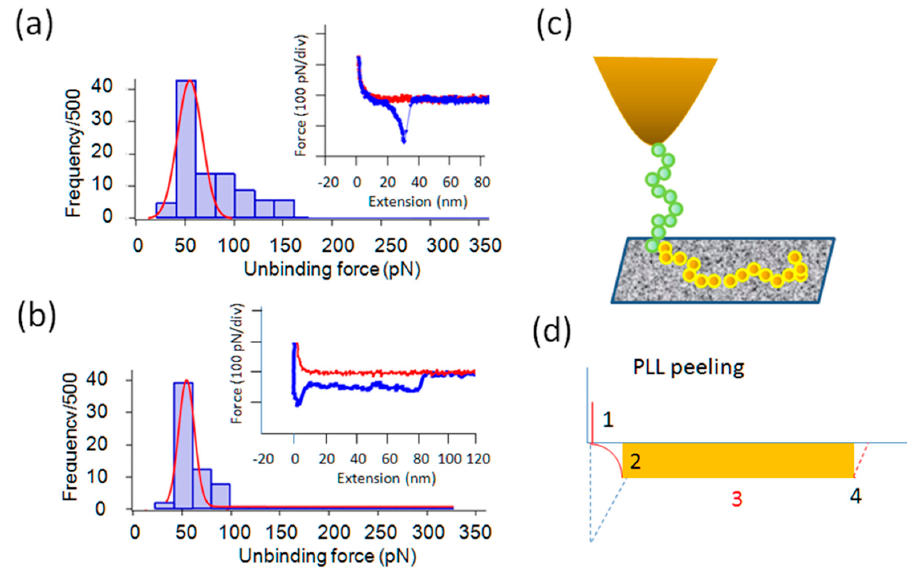
Figure 6. Results of lysine (Lys) and poly- L -lysine (PLL). ( a ) Histogram and force curve for Lys interaction with pyrite; ( b ) Histogram and polymer peeling/pull-out type force curve with a plateau for PLL. The binding frequency was relatively high for both Lys and PLL; ( c ) schematic explanation of binding and unbinding (peeling in this case) of linearly adsorbed PLL (green for PEG and brown for PLL); and, ( d ) Schematic of extension of free polymer chain. From 1 to 2 (blue dotted line: non-specific interaction), peeling of polymer chain from 2 through 3 to the final detachment of the chain from the substrate at 4. The integrated area (orange box) gives the total work of chain peeling.